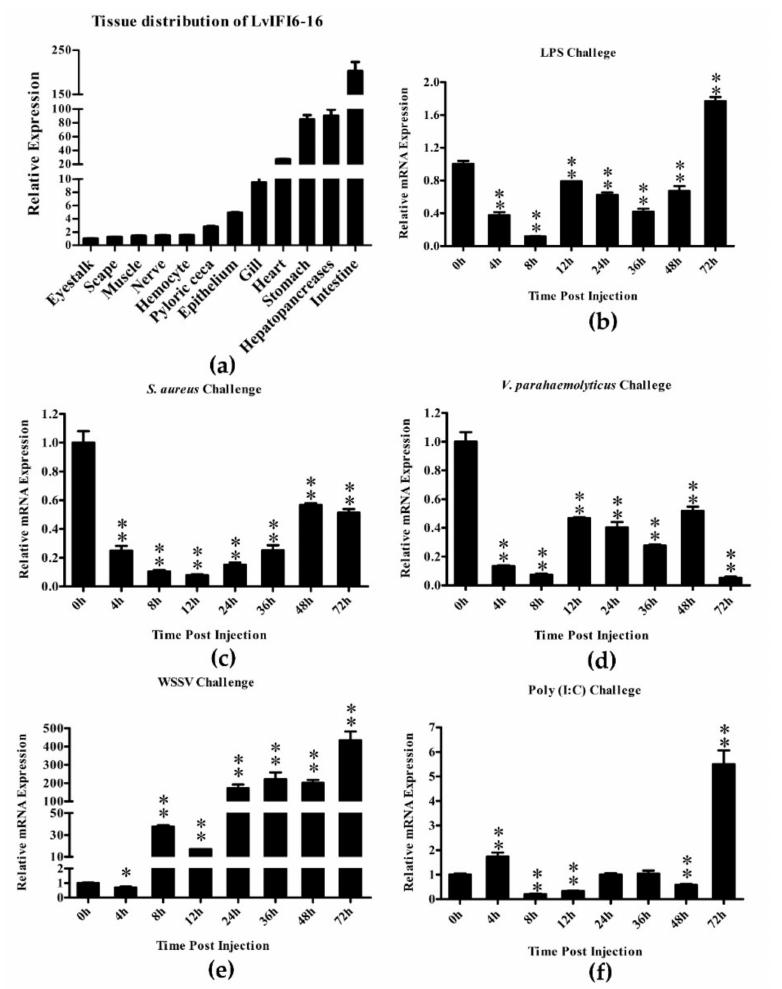
Figure 2. Tissue distribution of LvIFI6-16 in healthy L. vannamei and expression profiles of LvIFI6-16 in gills from pathogens or stimulants challenged L. vannamei . ( a ) Tissue distribution of LvIFI6- 16 in healthy L. vannamei . Expression level in the eyestalk was used as control and set to 1.0. ( b – f ) Expression profiles of LvIFI6-16 in gills from LPS ( b ), S. aureus ( c ), V. parahaemolyticus ( d ), WSSV ( e ) and Poly (I:C) ( f ) challenged shrimps. Bars indicated the mean ± SD of three samples and statistical significances were calculated by the Student’s t -test (* p < 0.05, ** p < 0.01). Experiments were performed three times with similar